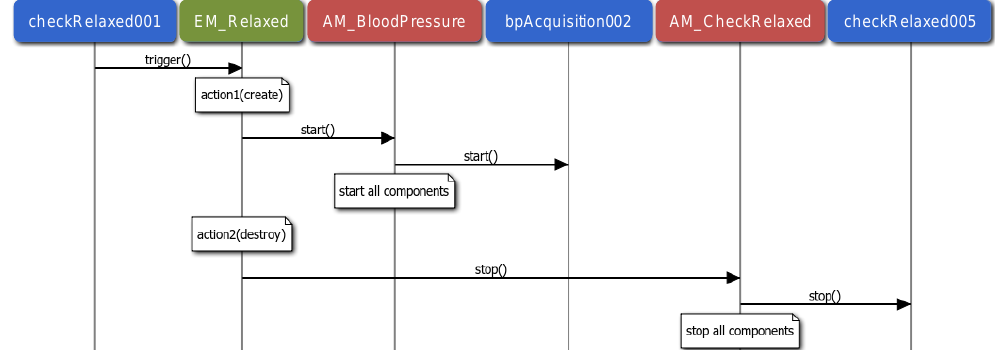
Figure 9. Sequence diagram related to the Relaxed internal event.